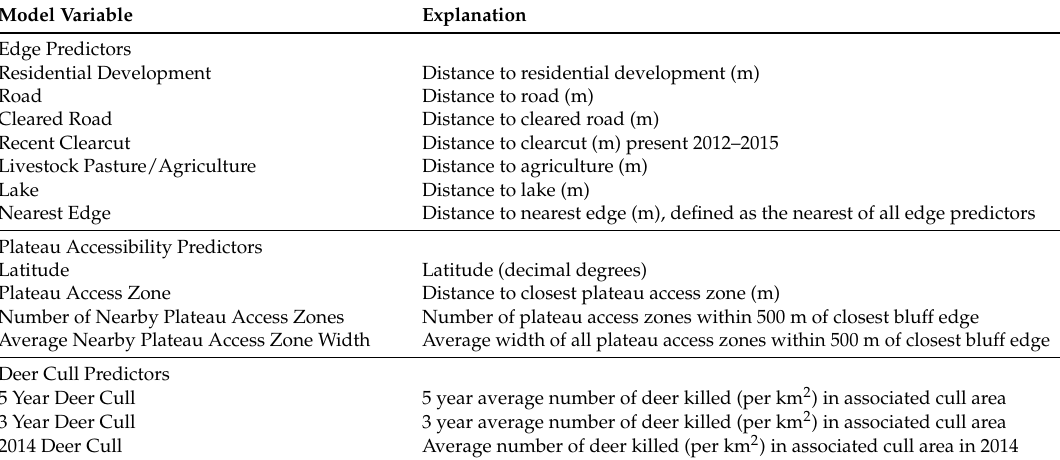
Table 1. Model variables for each predictor category with explanations of how they were derived. Values representing each variable is associated with each sample point (e.g., distance from sampling point to residential